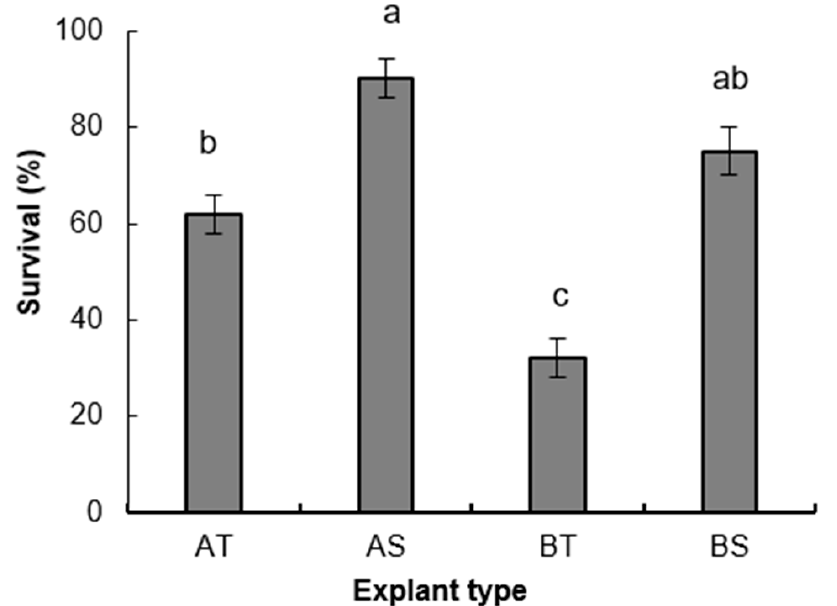
Figure 2. Survival (%) in different explant types of Cryptomeria japonica cultured in DCR medium [13], MS medium [14], and QL medium [15]. Apical explants > 1.5 cm (AT), apical explants < 1.0 cm (AS), basal explants > 1.5 cm (BT), and basal explants < 1.0 cm (BS). Data are presented as mean values ± S.E. Significant differences are indicated by different letters according to Tukey’s post hoc test ( p < 0.05).